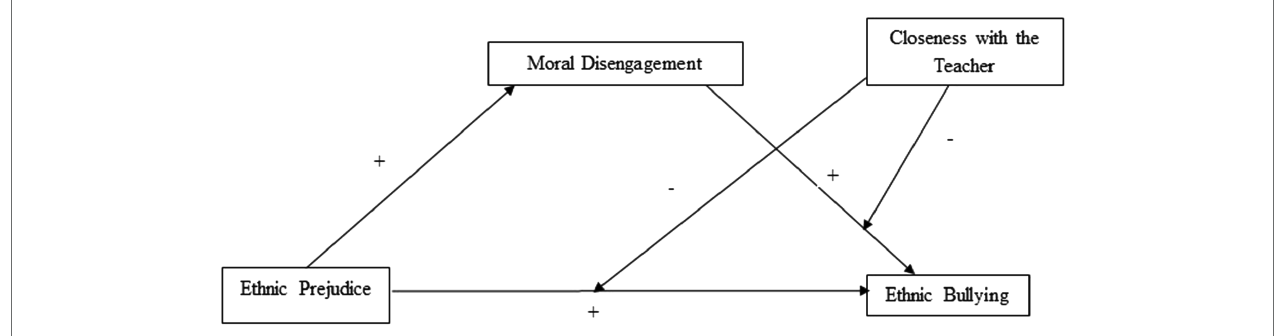
FIGURE 1 | Theoretical model in which ethnic prejudice is expected to affect ethnic bullying through moral disengagement and in which closeness with the teacher is expected to moderate direct and indirect